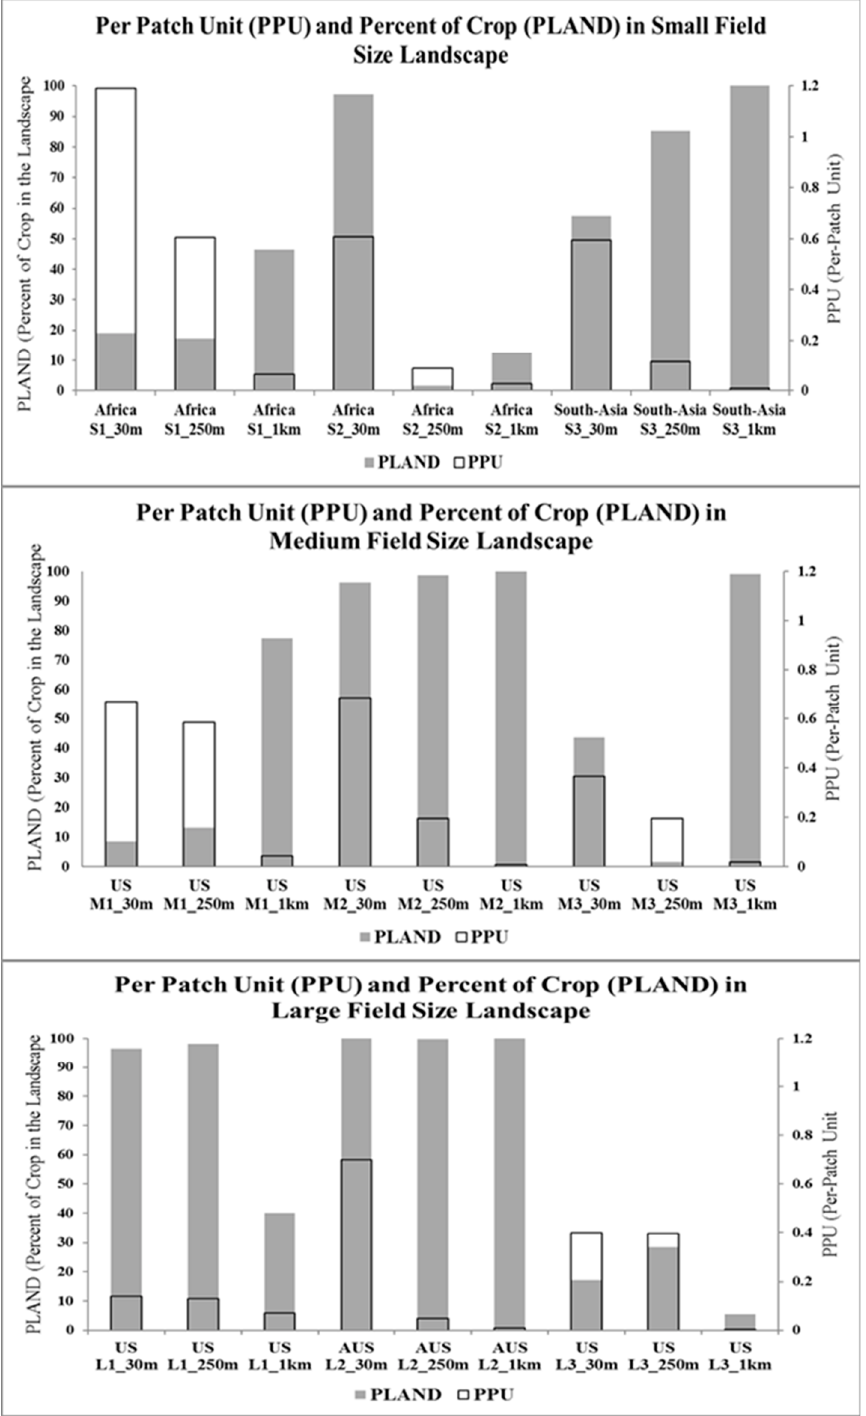
Figure 13. The comparison of landscape heterogeneity and area proportions in small, medium, and large field sizes.